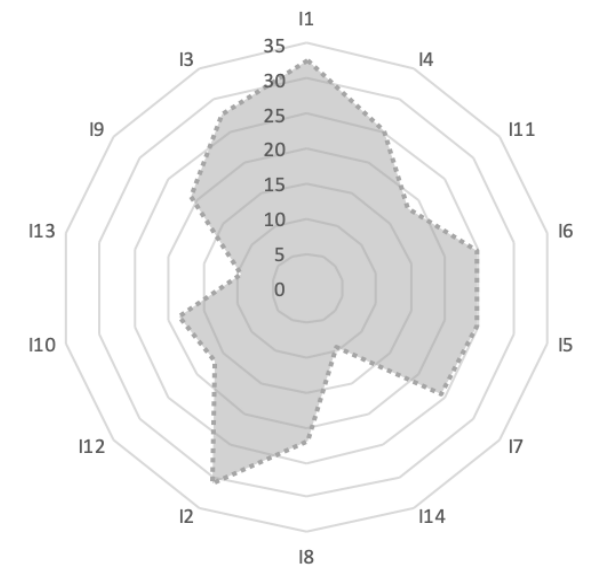
Figure 6. Results of third Delphi round (mean WTP values).